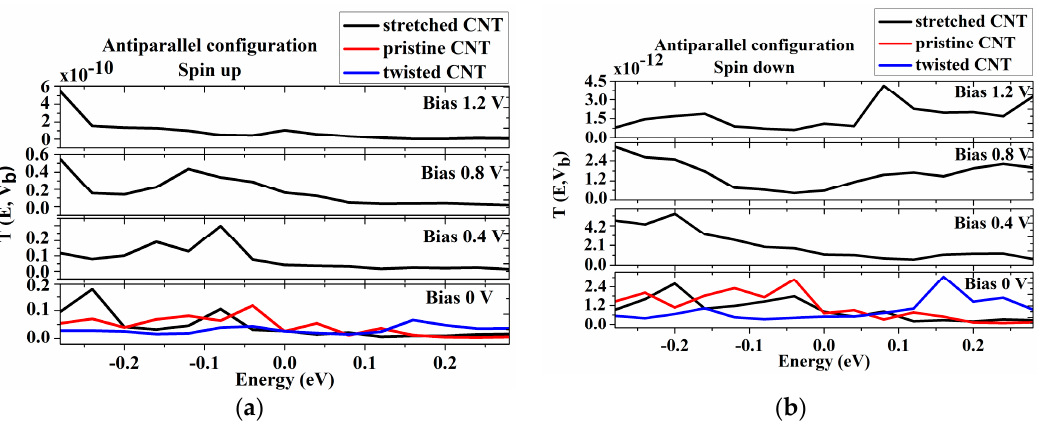
Figure 7. Transmission spectrum T (E, V b ) with respect to energy ranging from − 0.3 eV to +0.3 eV for different applied voltages for APC. At zero volts, the comparative transmission probability for all three structures, shown separately for spin ‐ up ( a ) and spin ‐ down ( b ).